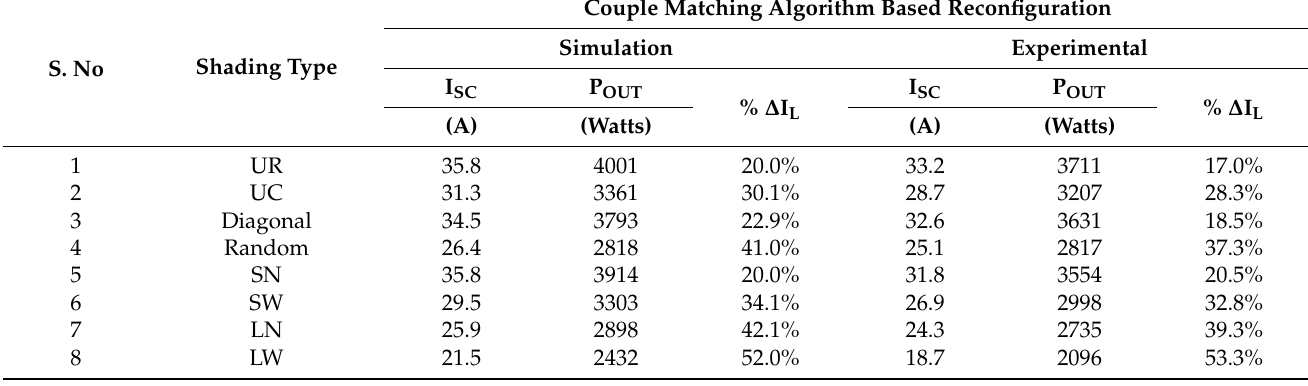
Table 5. Output Power of Proposed Method.